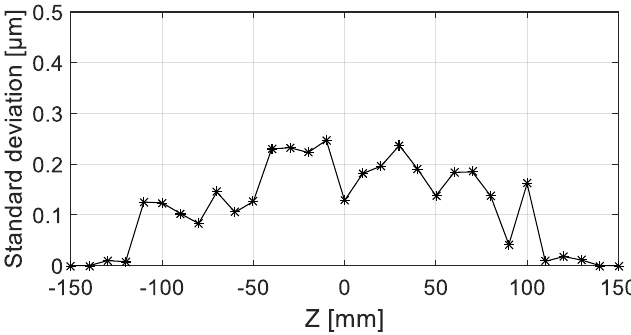
Figure 22. Cylindrical spraying: sample standard deviation of each measurement point.